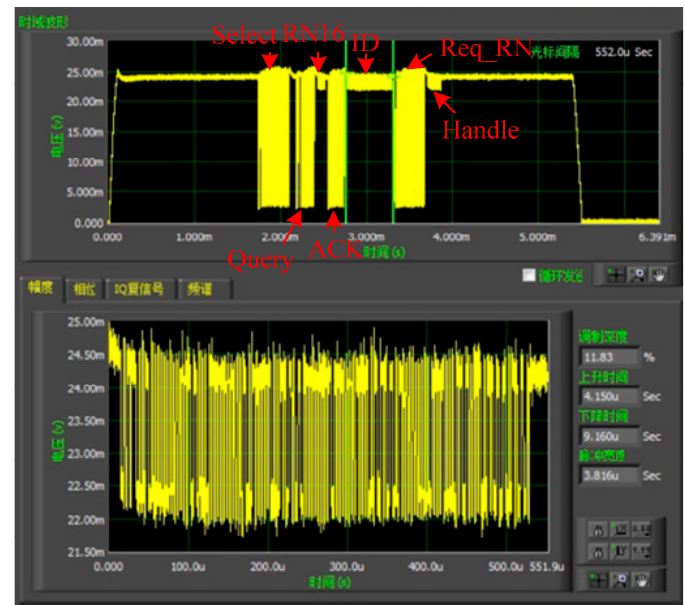
Figure 12. The result of communication test in the laboratory.